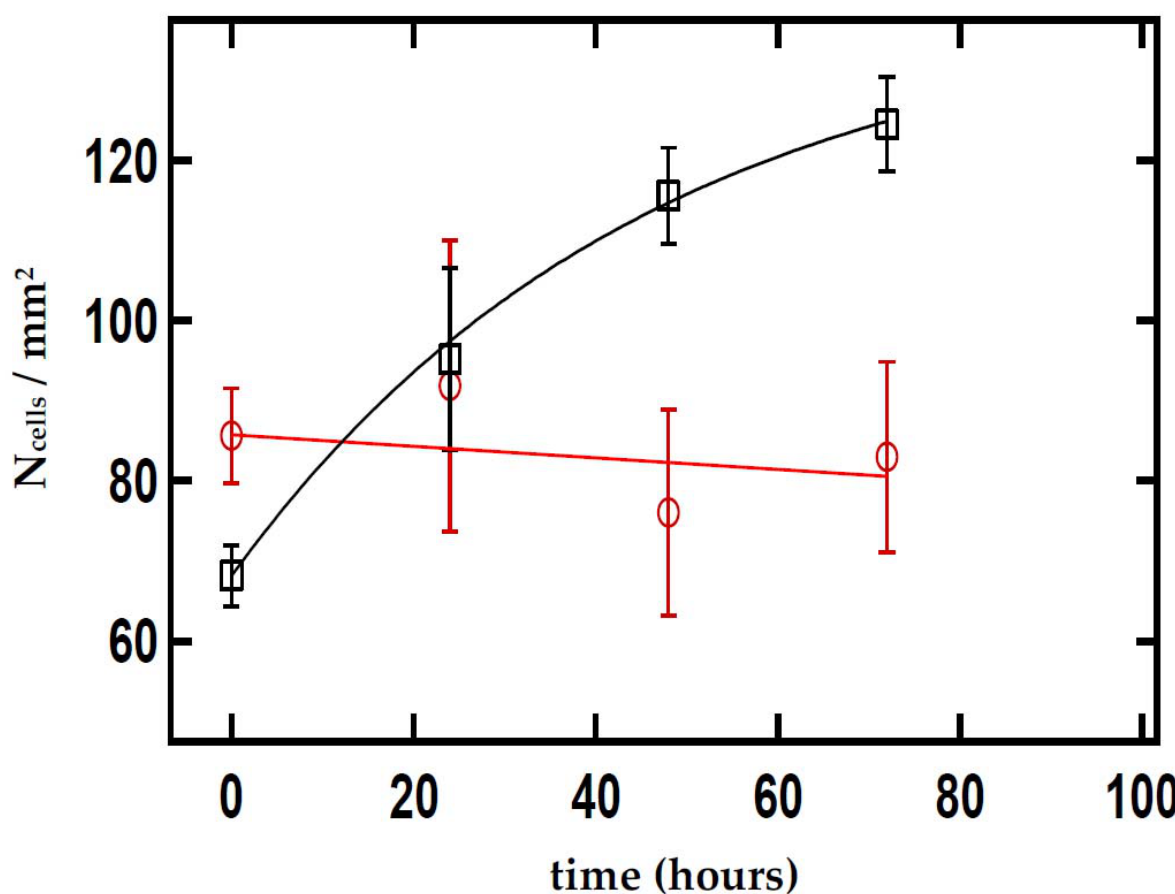
Figure 4. The open squares and circles represent the dependence of carcinoma cell density fed with normal media and media mixed with CaS nanoclusters. The total amount of Ca 2+ in the nanocluster dispersion is 4 × 10 − 8 moles. The time t = 0 h corresponds to the time of the initial dose. The solid black curve and red line are to guide the eyes through the discussion and do not represent a model fit. The spectrum of the dispersion containing the CaS nanoclusters used for the measurements is indicated in the insert at the lower right ‐ hand side of the figure.